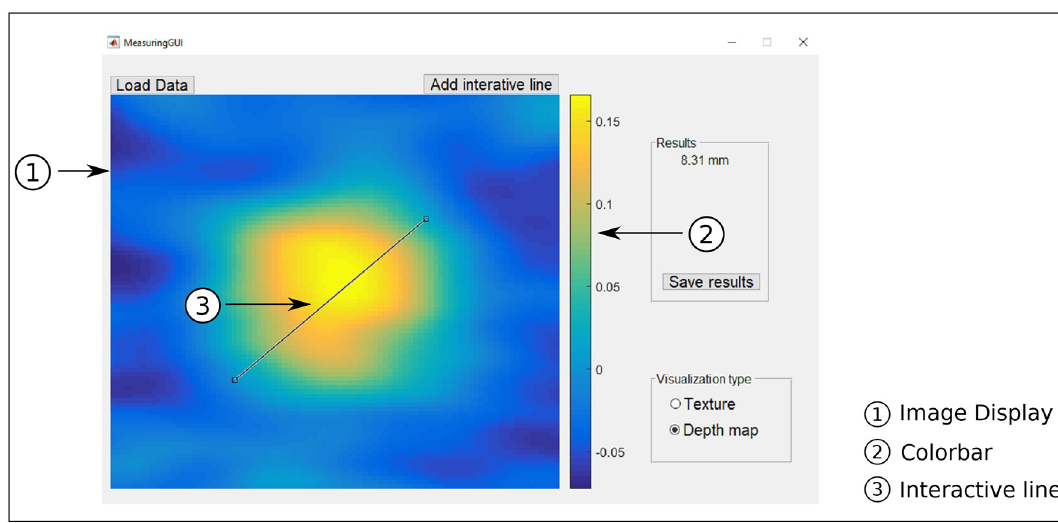
Fig 7. Custom user interface for the manual reference measurement of the wheal diameter. Depth colorbar units in mm.